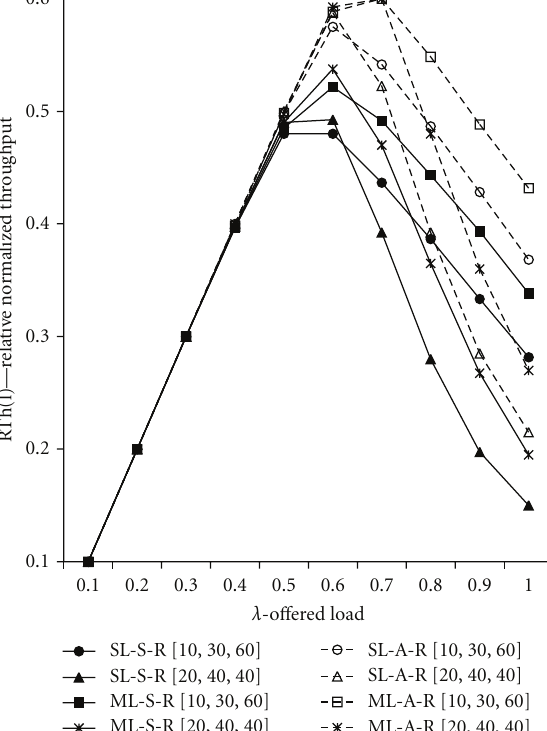
Figure 4: Relative normalized throughput of medium priority pa- ckets versus o ff ered load.